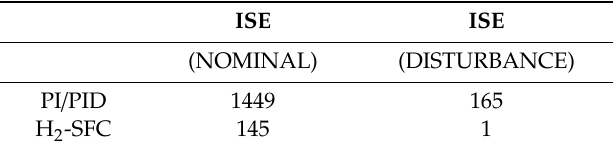
Table 2. First performance index (ISE) in the presence of external disturbances of the PI/PID and H 2 -SFC controllers. ISE ISE ISE ISE (NOMINAL)